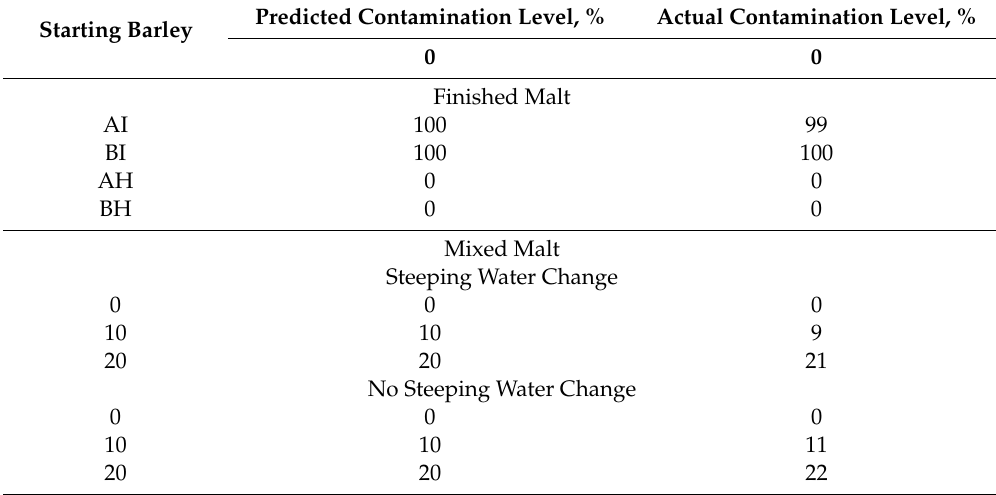
Table 2. The results of microbiological analysis of starting barley, finished malt, and mixed malt. Predicted Contamination Level, % Actual Contamination Level, % Starting Barley 0 0 Finished Malt